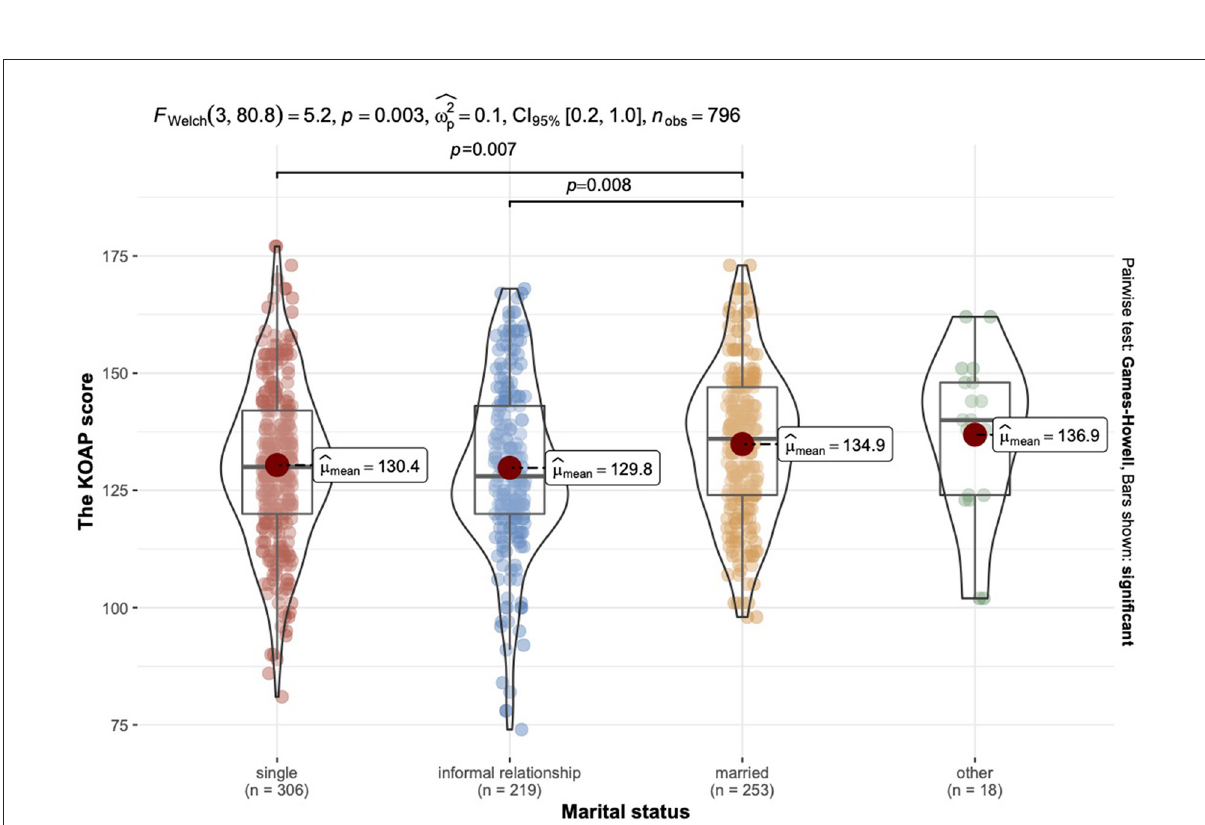
FIGURE2 Comparative characteristics of the KAOP mean scores grouped by marital